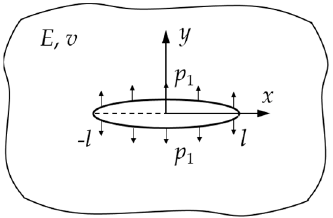
Figure 6. Schematic view of the crack problem in homogeneous medium.